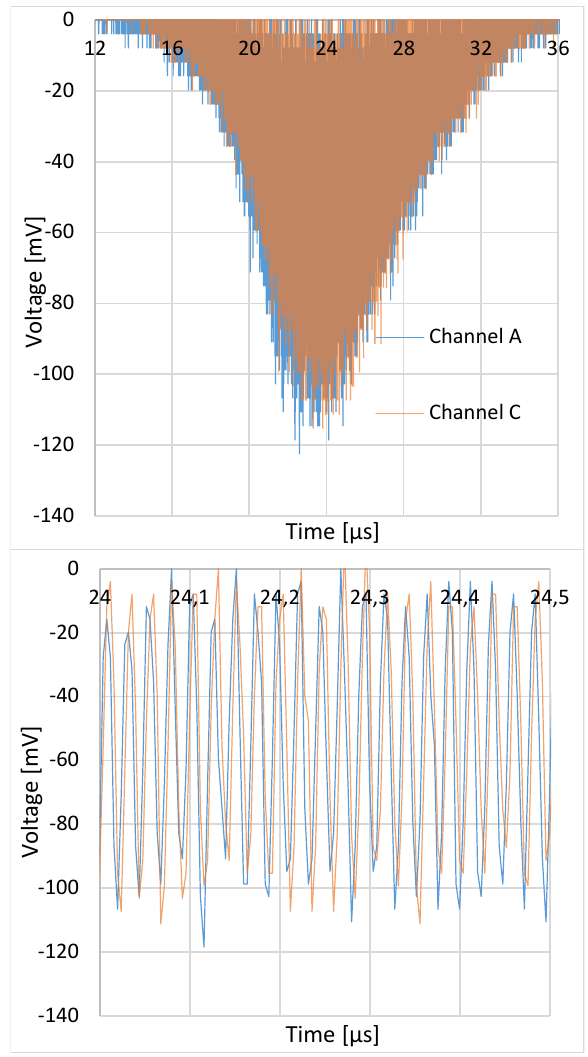
Fig. 2 Doppler Burst acquired by the PDA system. Top: The whole burst, bottom: detail in the time resolved signal.